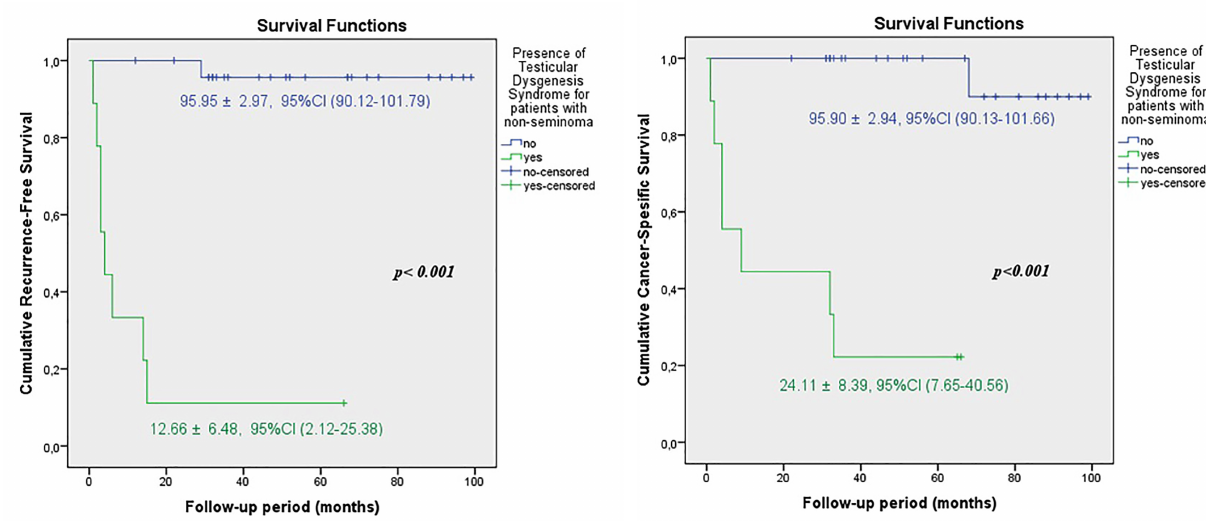
Figure 4A - Kaplan-Meier plots of recurrence-free survival according to presence of Testicular Dysgenesis Syndrome for patients with non-seminoma.